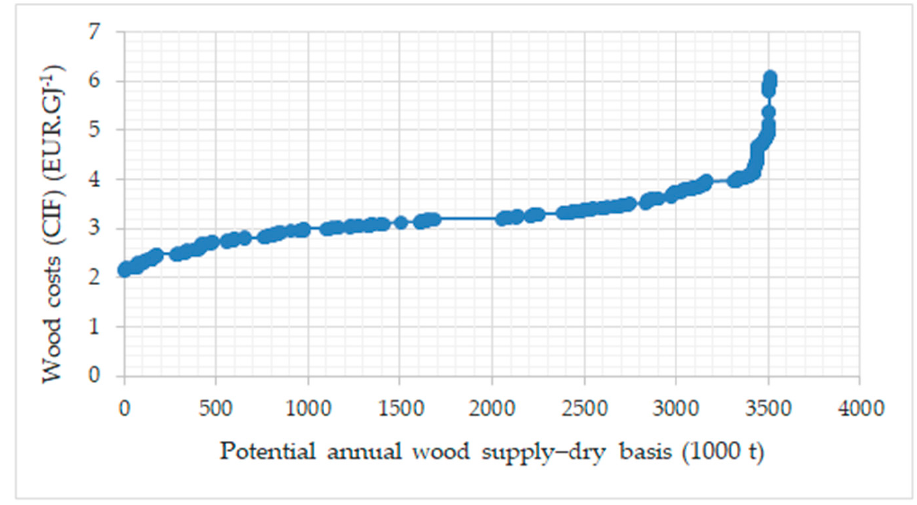
Figure 5. Wood (Eucalyptus) supply curve at REVAP, supposing the production in five sites and the bulk of the transport by rail.